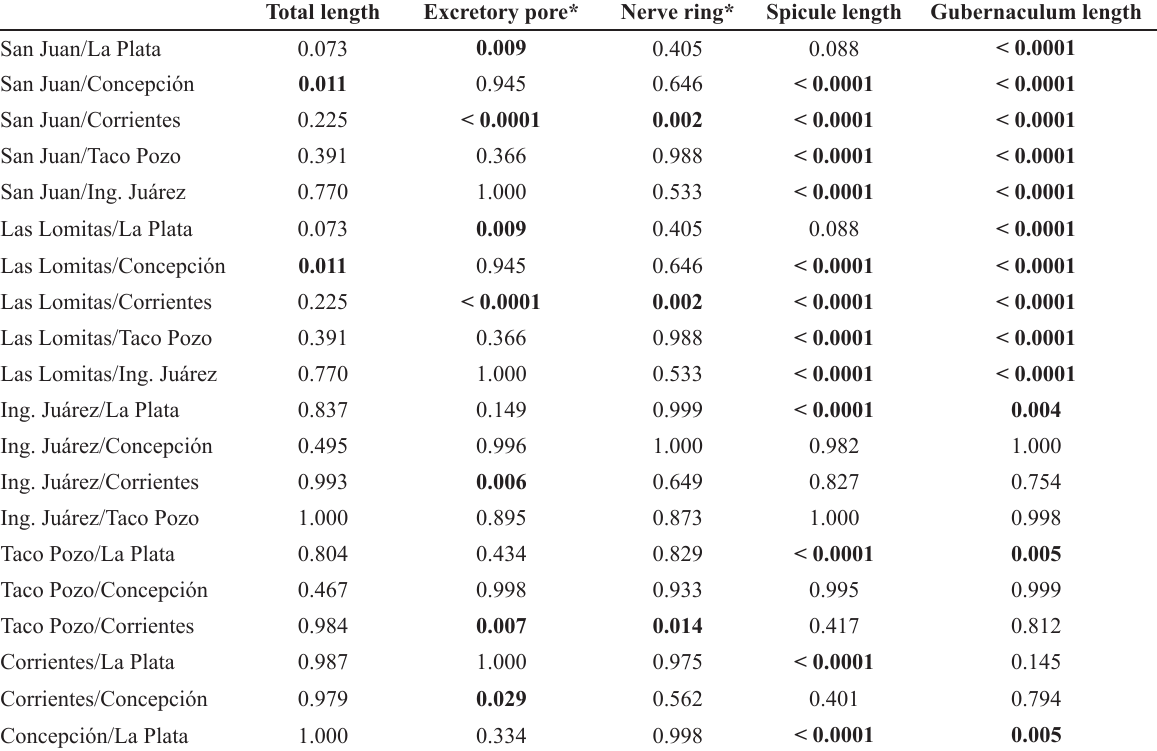
P values for pair comparisons of morphological features of males of A. hylambatis from different localities in Argentina. Significant values in